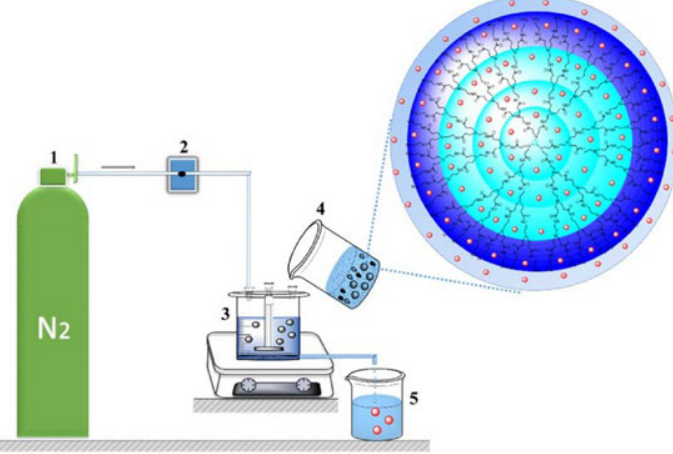
Figure 2. Schematic diagram of batch complexation and polymer assisted ultrafiltration (PAUF) assembly. 1- Cylinder with compressed air (pressure trap); 2- reducer with diaphragm valve and pressure gauge; 3- UF stirred cell; 4- batch stirred tank for complexation reaction (preparation of feed solution) and 5- permeate solution.